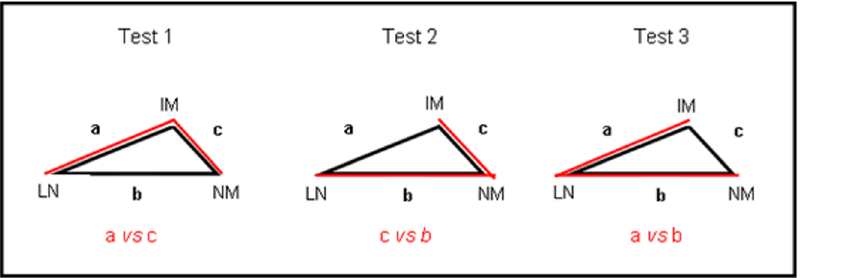
Figure 6. Three tests used for the matched-pairs t -test analyses for three different combinations of the three samples analysed using HTS for subjects who underwent colonoscopy. 2 1m, 2 1w, sample obtained 1 month, 1 week pre-colonoscopy, LS, the last post- colonoscopy sample obtained for each patient. Test 1 compares the mean distances of a and c, test 2, c and b, and test 3, a and b.